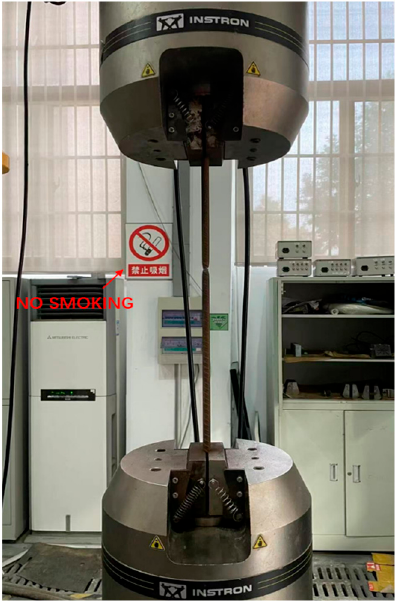
Figure 2. Strength test of the concrete block.